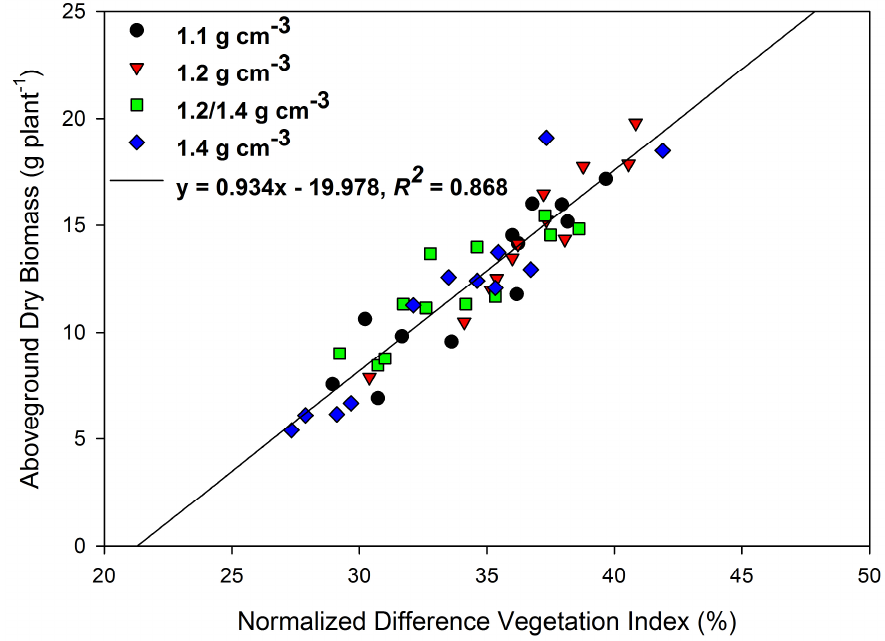
Figure 5. Faba bean aboveground dry biomass and average normalized difference vegetation index (NDVI) as a function of bulk density treatments. The compaction treatment effects on dry aboveground biomass and NDVI are shown. The bulk density that was representative of the best growing condition in our study was 1.2 g cm − 3 and generally showed the highest biomass production. One plant was grown per experimental